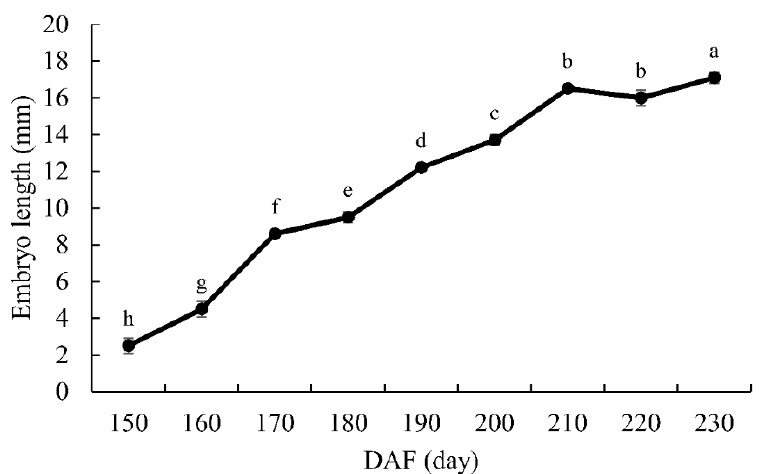
Figure 2. Changes in embryo length during the seed development of Ginkgo biloba ‘Jiafozhi’. Data are the mean ( ± SD) of three replicates, and bars labeled with different lowercase letters are significant at p < 0.05. Table 1. Multiple comparisons of the external morphological changes of different stages during embryo development of Ginkgo biloba ‘Jiafozhi’.